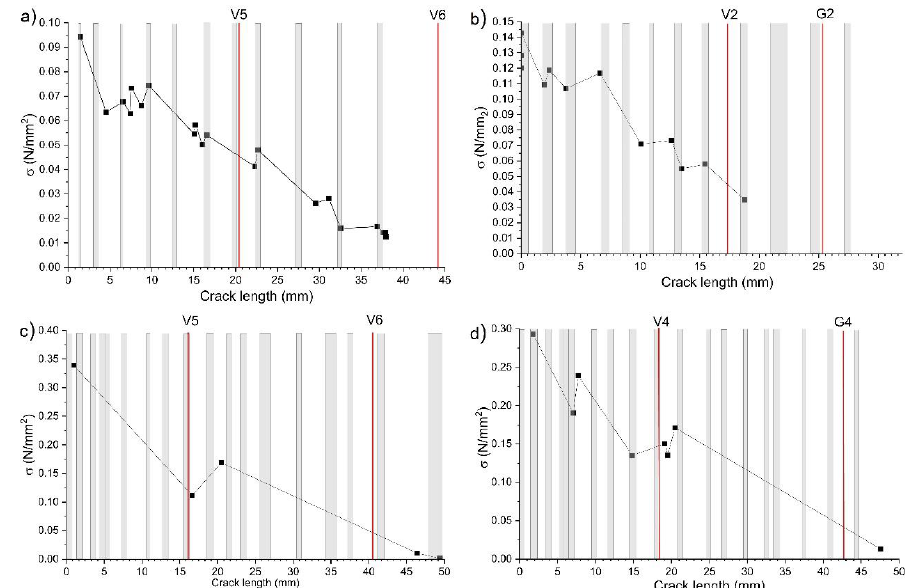
Figure 3. Crack length (mm)/σ (N/mm 2 ) curves obtained for 4 of the tested samples. ( a ) STP1; ( b ) SP2.2; ( c ) STO1; ( d ) SO1.1. Red lines designate the position of the AE sensors. V, Vallen; G, Glaser. Grey areas represent the thickness of tree rings (dark areas).